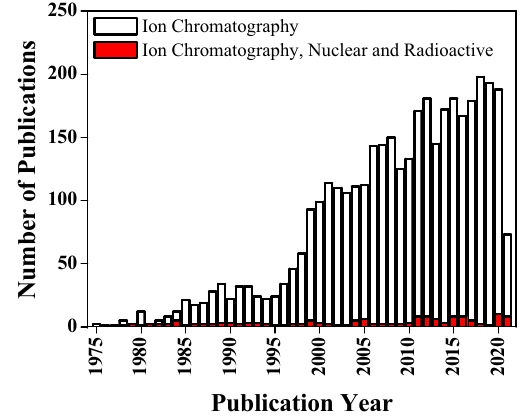
Figure 3: Bar diagram illustrating the number of papers published on IC from 1975 till date based on the search results of PubMed. The fi gure legends show the terms searched in the title and abstract of the published